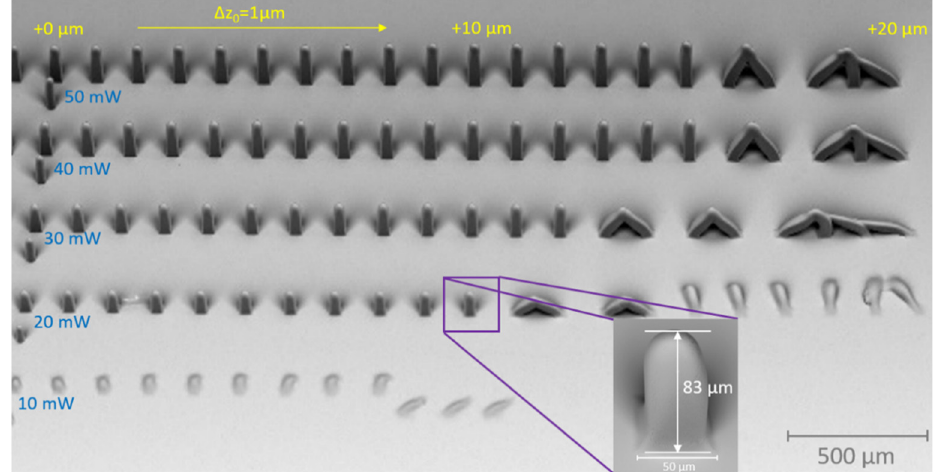
Figure 8. SEM (scanning electron microscopy) images of cuboids fabricated by 2PP with variation of fabrication parameters for ACM 2:8. For each row the laser power was modified (blue labeling). The focusing offset with respect to the detected interface is varied within each row (yellow labeling). In the inset, a close-up of one of the cuboids is shown. Scale bars are 500 µm for overview image and 50 µm for close-up